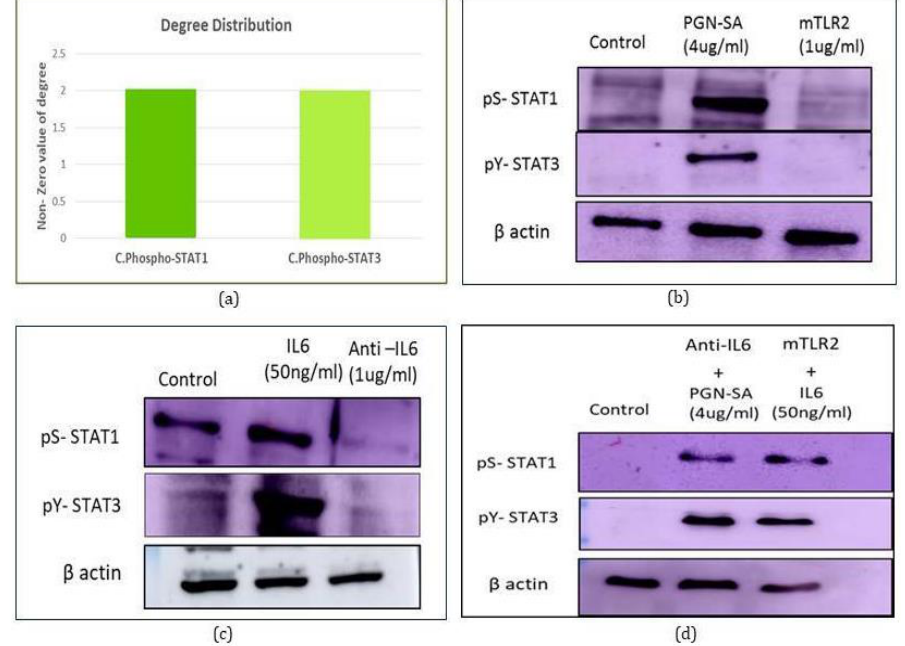
Figure 4. Identification of cross talks between TLR2/TLR6-IL6 signaling pathways ( a ) Degree distribution of cross talks identified through network analysis ( b , c ) Expression levels of phosphorylated STAT1 (S727) and STAT3 (Y705) during activation and inhibition of their respective pathway ( d ) Western blotting was used to check expression levels of phosphorylated STAT1 (S727) and STAT3 (Y705) during activation of one pathway & inhibition of another pathway, and vice versa. For all western blot experiments, an equal amount of protein was resolved and blotted for b-actin to ensure equal loading. The experiments were performed thrice. Results from one representative experiment are